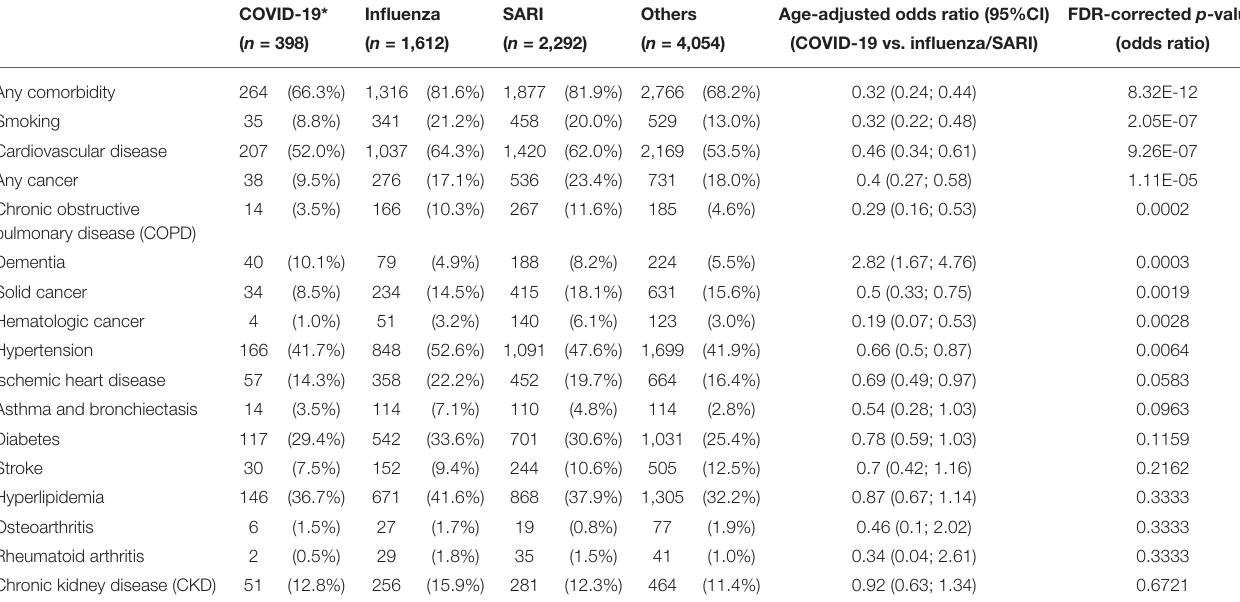
TABLE 2 | Comorbidities prevalence and age-adjusted odds ratios among study patients at admission and comparison between disease groups.